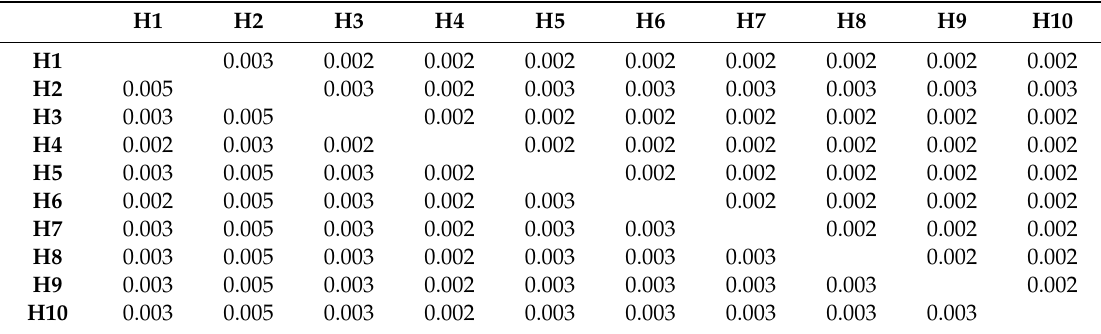
Table11. EstimatesofevolutionarydivergencebetweenCOIhaplotypes(H1-H10*)basedonp-distances (below the diagonal). Standard error estimates are shown above the diagonal and were obtained by a bootstrap procedure (500